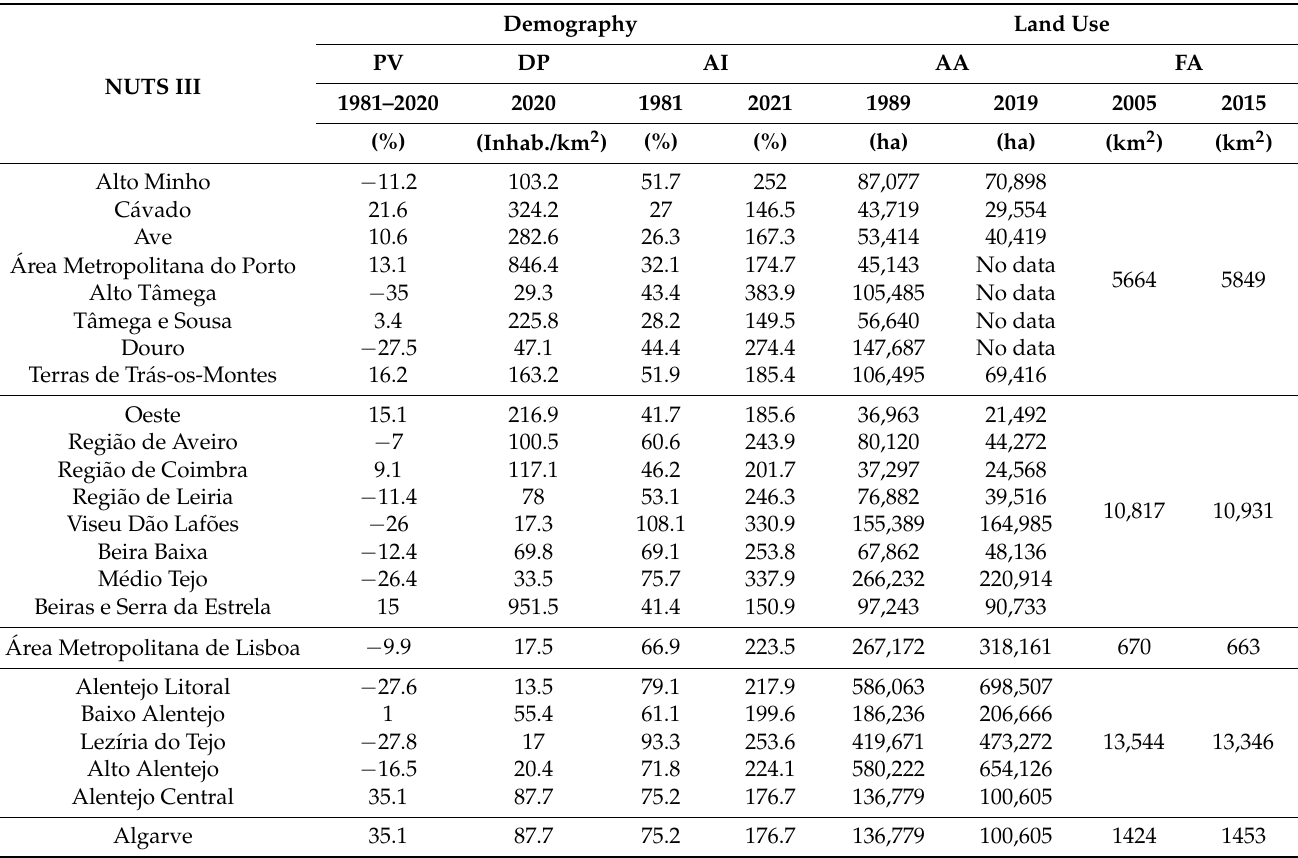
Table 1. Demography and land use characteristics of the sub-regions of Portugal (Portugal mainland NUTS III, where PV is the Population Variation; DP is the Density of Population; AI is the Ageing Index; AA is the Agriculture Area; and FA is the Portugal mainland NUTS II Forest